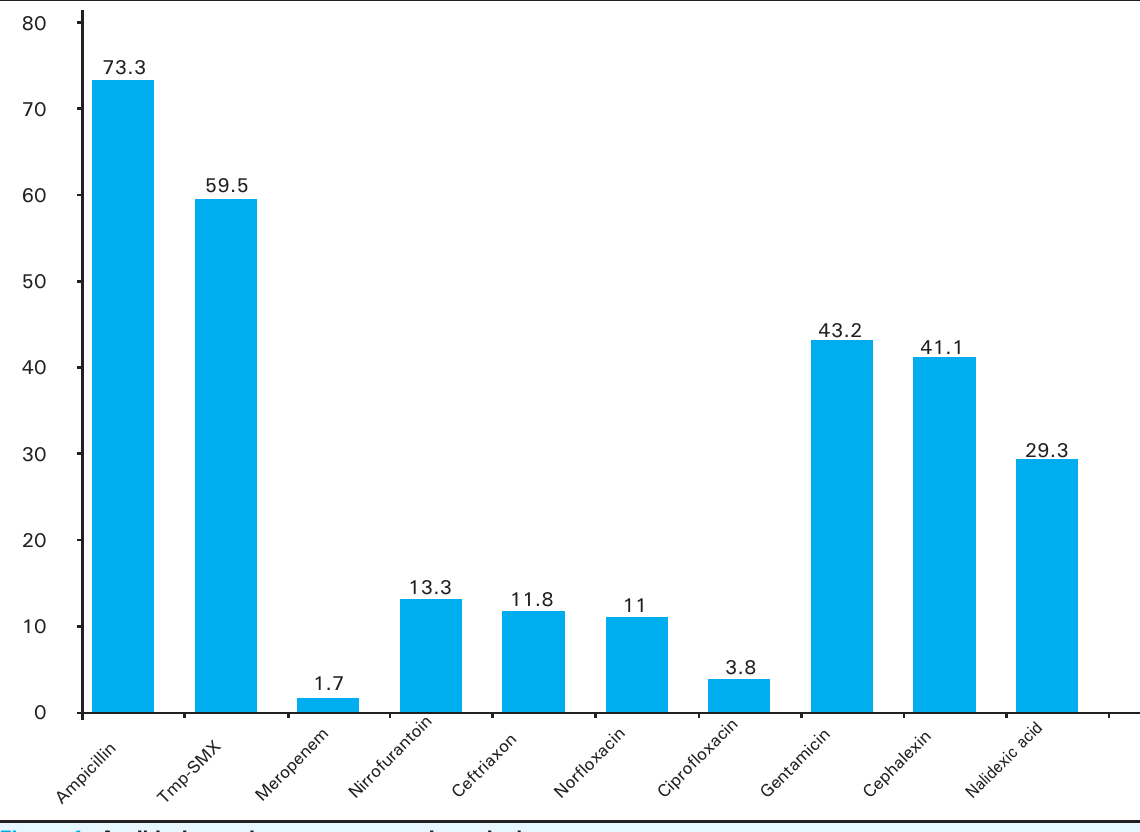
figure 1. Antibiotics resistance among urinary